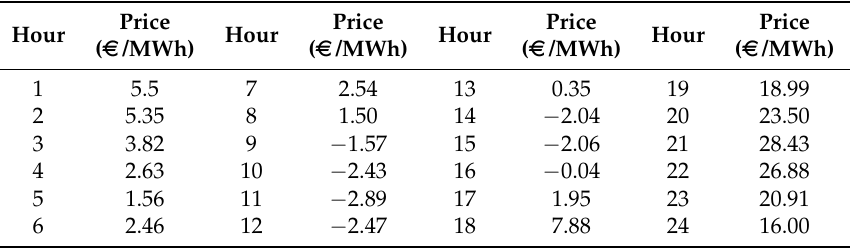
Table 1. Day-ahead market prices ( λ da